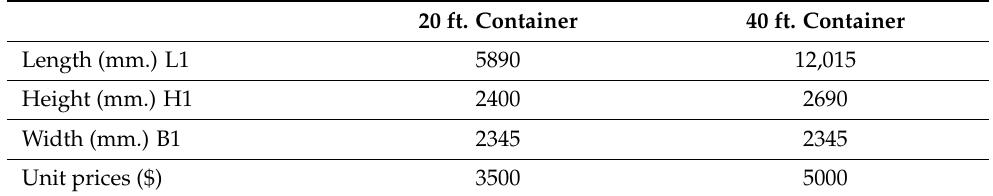
20 ft. Container 20 ft.